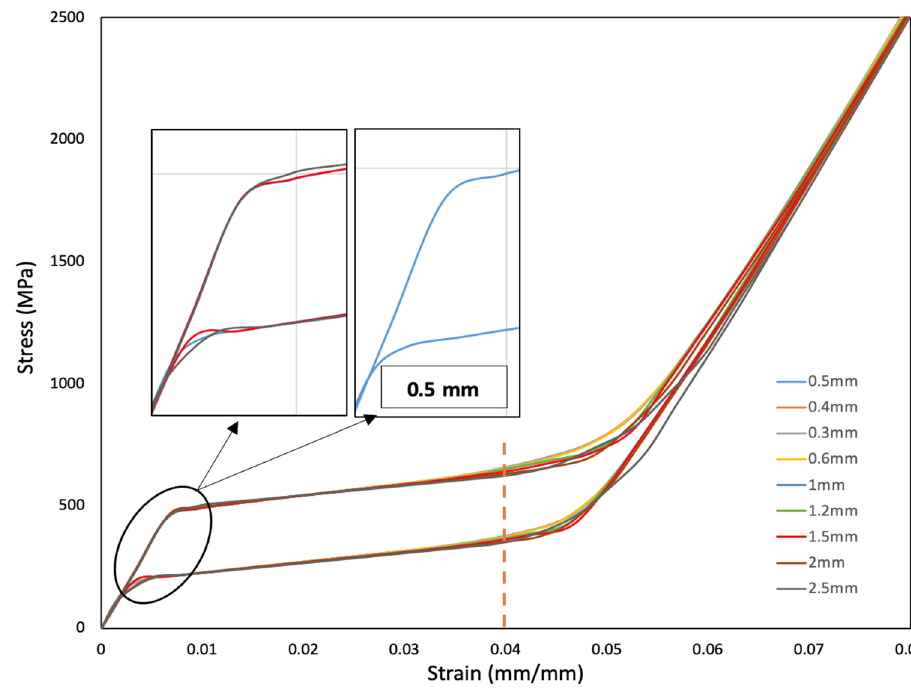
Figure 9. Stress–strain graph for mesh convergence study.